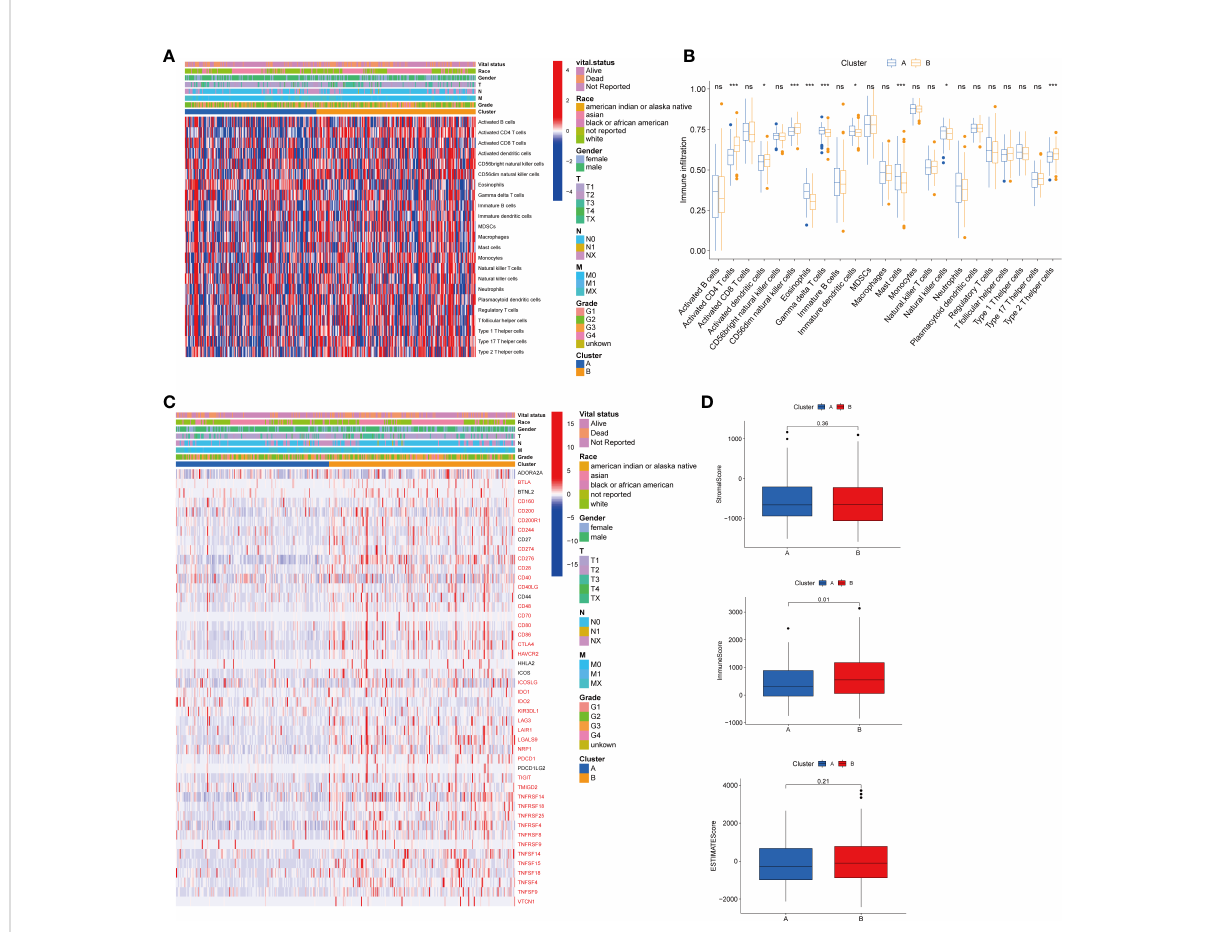
FIGURE 4 Correlations of tumor immune cell microenvironments and two HCC subtypes. (A) Heatmap of the tumor-in fi ltrating cells and clinical features in two HCC subtypes. (B) Expression abundance of 23 in fi ltrating immune cell types in the two HCC subtypes. (C) Immune checkpoints heatmap between the two subtypes, the red mark representing the checkpoints that are differentially expressed, with p < 0.05. (D) Correlations between the TME score and the two HCC subtypes. HCC, hepatocellular carcinoma; TME, tumor microenvironment. *p < 0.05, ***p < 0.001, ns, no signi fi cant